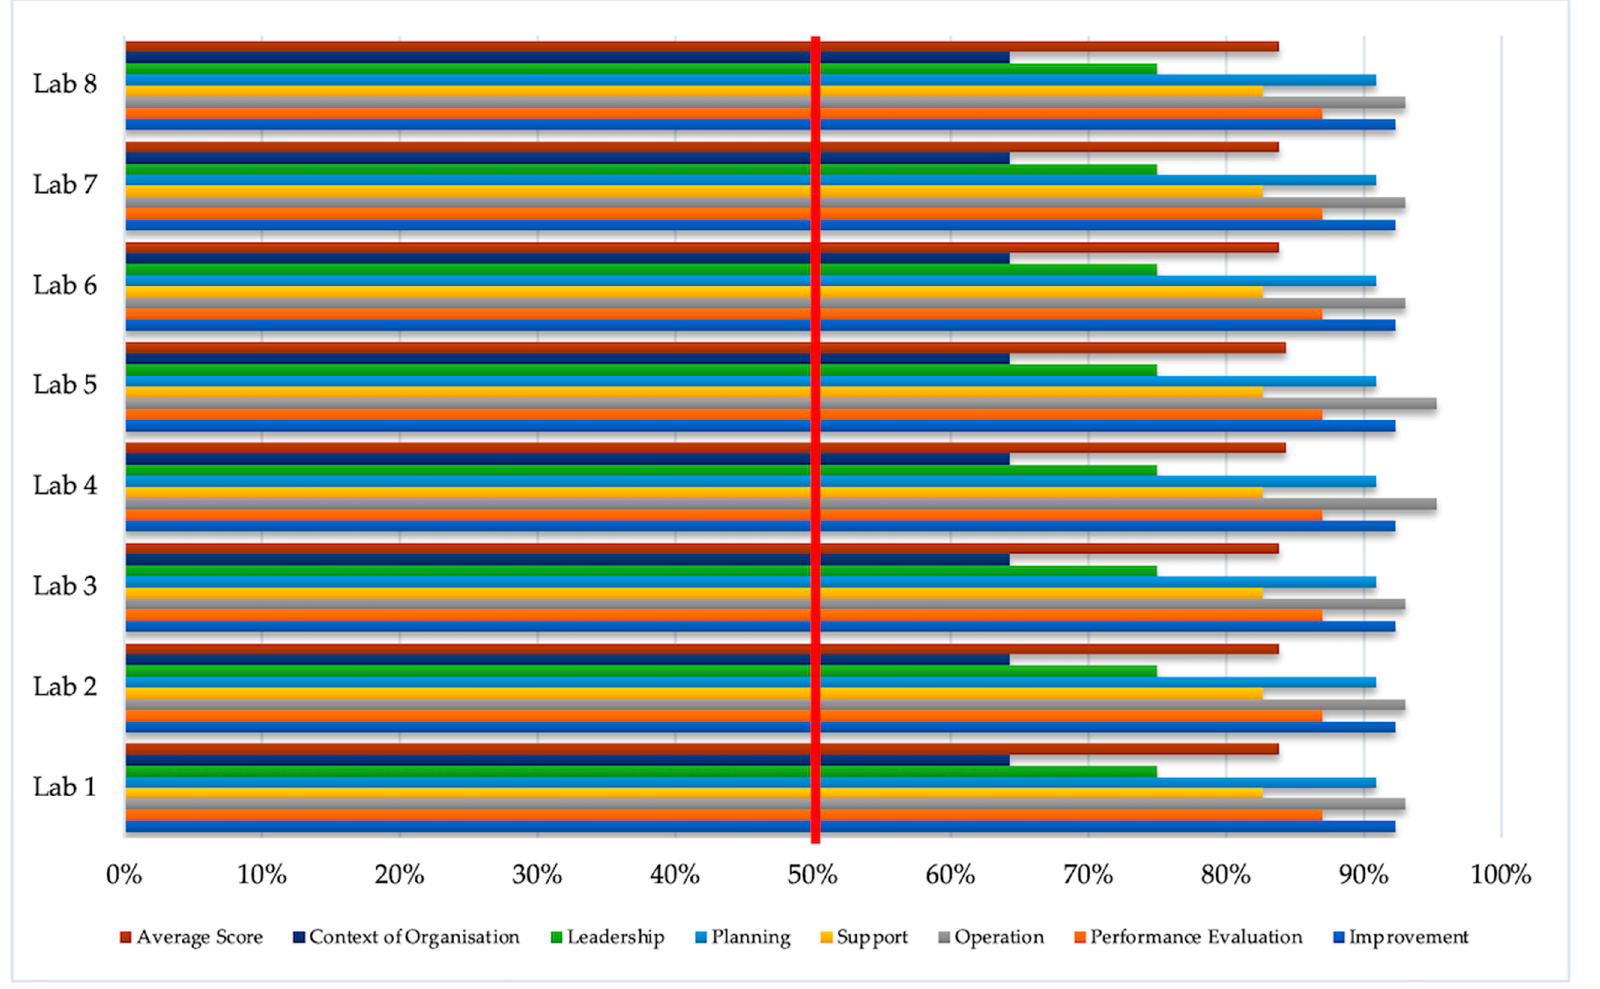
Figure 2. Total score of bio-risk management implementation by element.